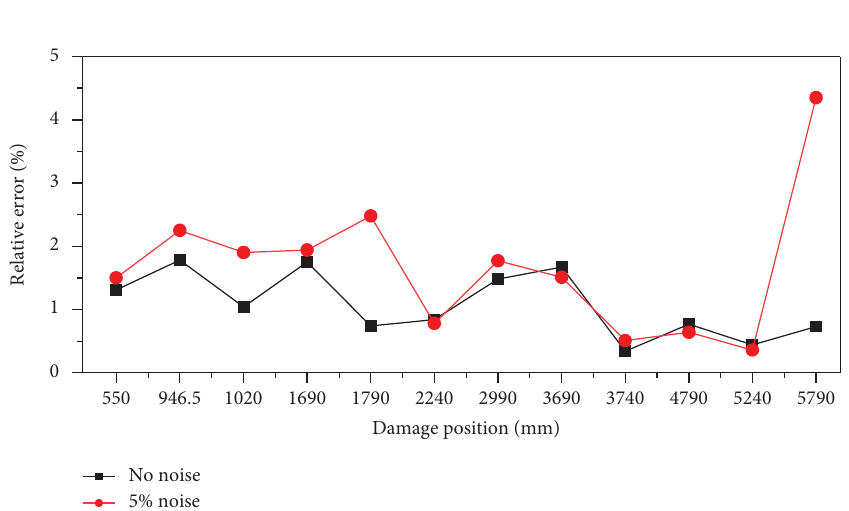
Figure 17: GA-BP neural network localization results of fnite element damage conditions.